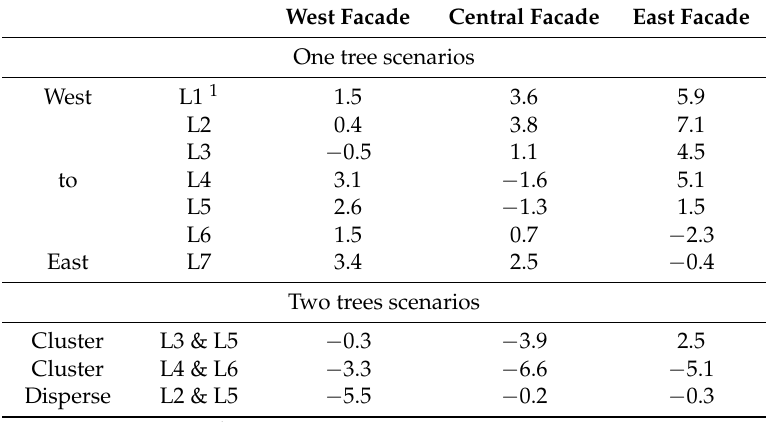
Table 5. Hourly shading benefits comparison for each experimental group (Referring to Figure 3 for tree locations, temperature unit is ◦